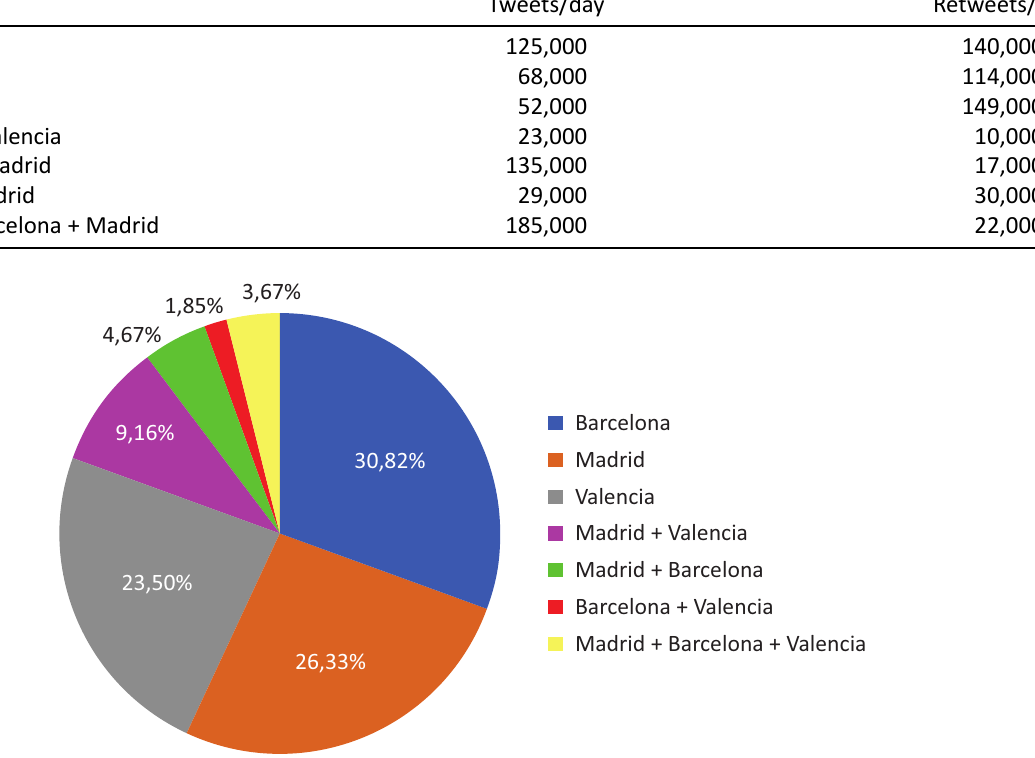
Figure 1. Percentage of users in each group according to their influence by